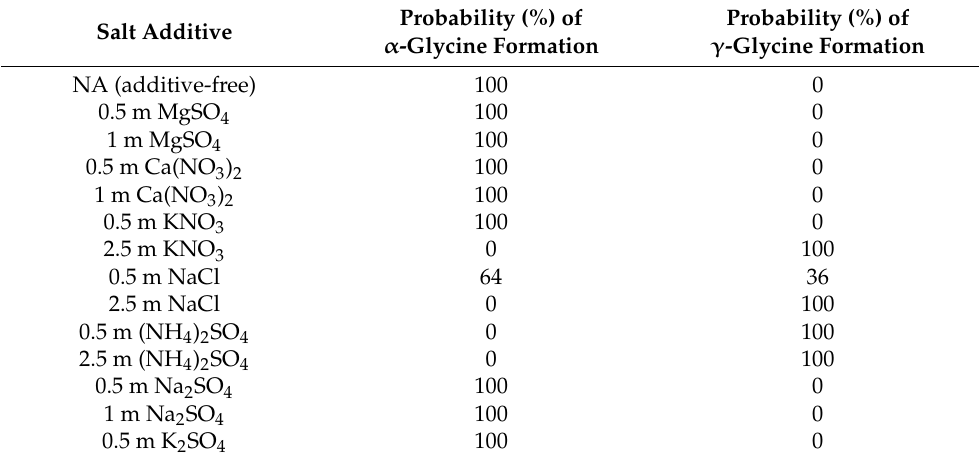
Table 2. The polymorphic outcome of glycine primary nucleation by cooling of its aqueous solutions with salt additives. Probability (%) of Probability (%) of Salt Additive α -Glycine Formation γ -Glycine Formation NA (additive-free) 100 0 0.5 m MgSO 4 100 0 1 m MgSO 4